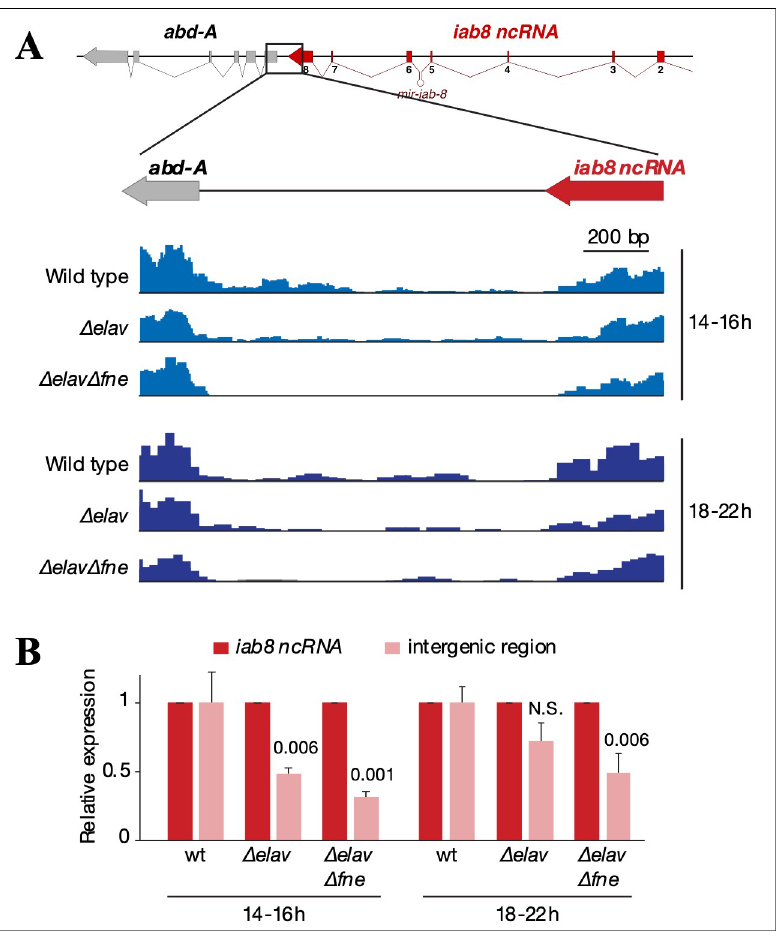
Fig 7. The intergenic transcribed region is downregulated in Δ elav and Δ elav Δ fne embryos. A. mRNA-seq signal tracks for the boxed gene region, representing expression of polyadenylated RNAs in whole embryos of the indicated genotypes, at two different times after egg laying (AEL). mRNA-seq data are from Carrasco et al., 2020 [20]. B. RT- qPCR quantification of iab8 ncRNA and the intergenic region RNA in wild-type, Δ elav , and Δ elav Δ fne embryos. RNA was extracted from whole embryos 14-16h AEL (after egg laying) and 18-22h AEL. RNA levels were normalized to iab8 ncRNA levels. Error bars represent mean ± SD of three biological replicates (10–15 embryos per replicate) for each genotype. P-values are indicated (one-way ANOVA testing the difference to wild type). As typical for ELAV- dependent RNAs, the intergenic region is more significantly downregulated in Δ elav Δ fne than in Δ elav embryos at both time points. N.S.: